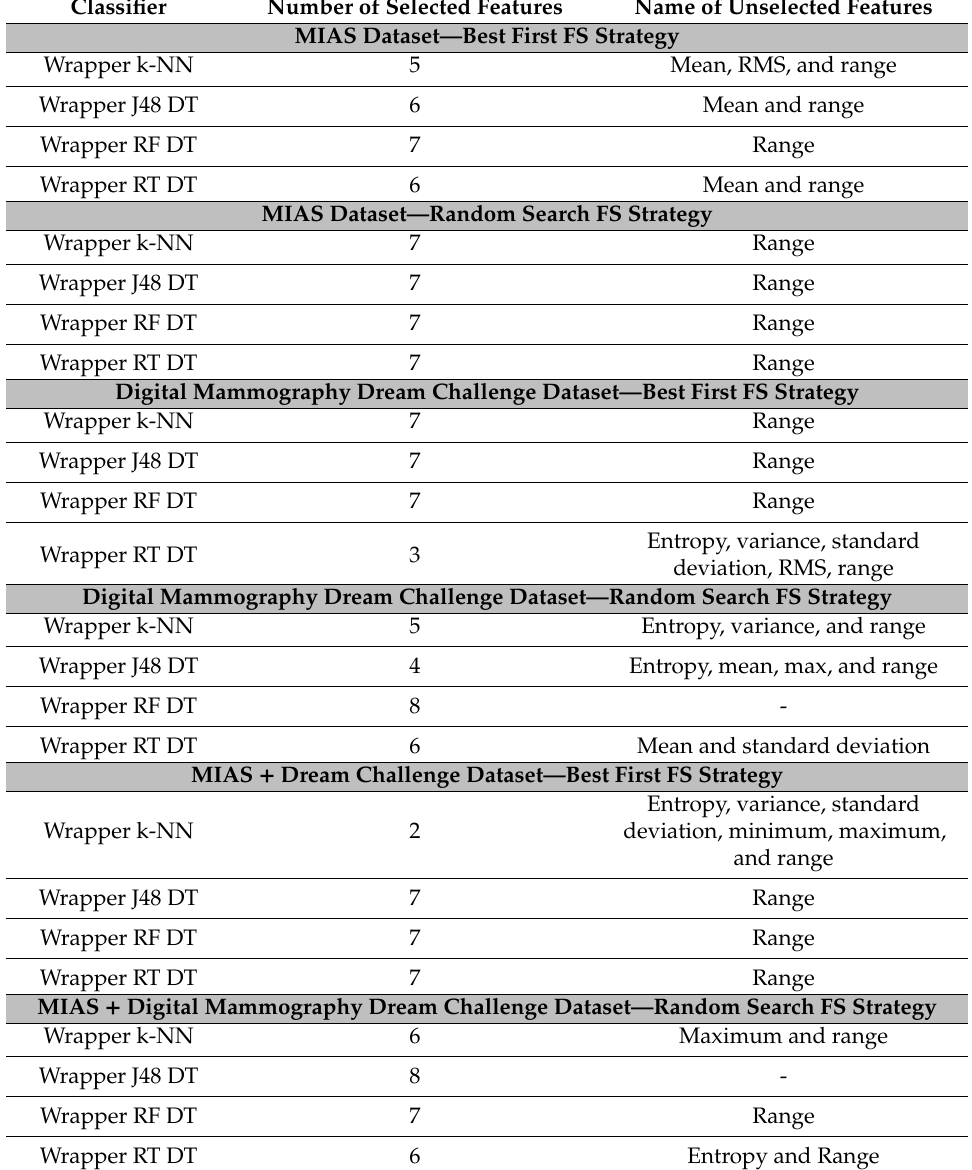
Table 12. The name of the unselected features for each FS method for breast cancer